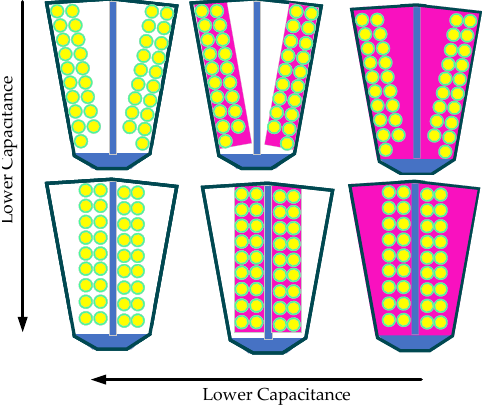
Figure 10. Winding position and